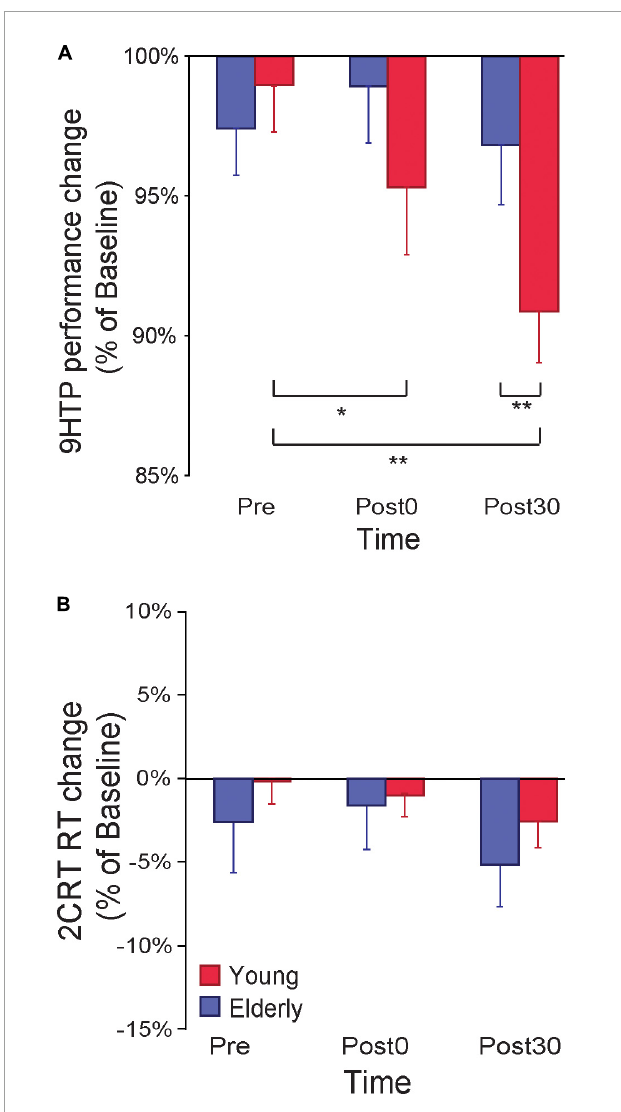
FIGURE2 (A) 9-Hole Peg Test (9HPT) performance improved